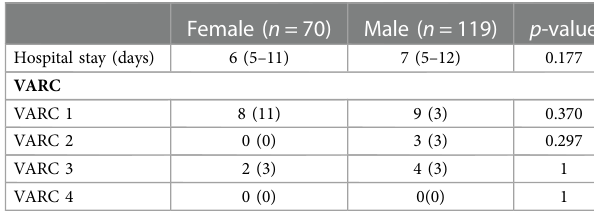
TABLE 7 Comparison of hospital stay and VARC-3 bleeding complications by